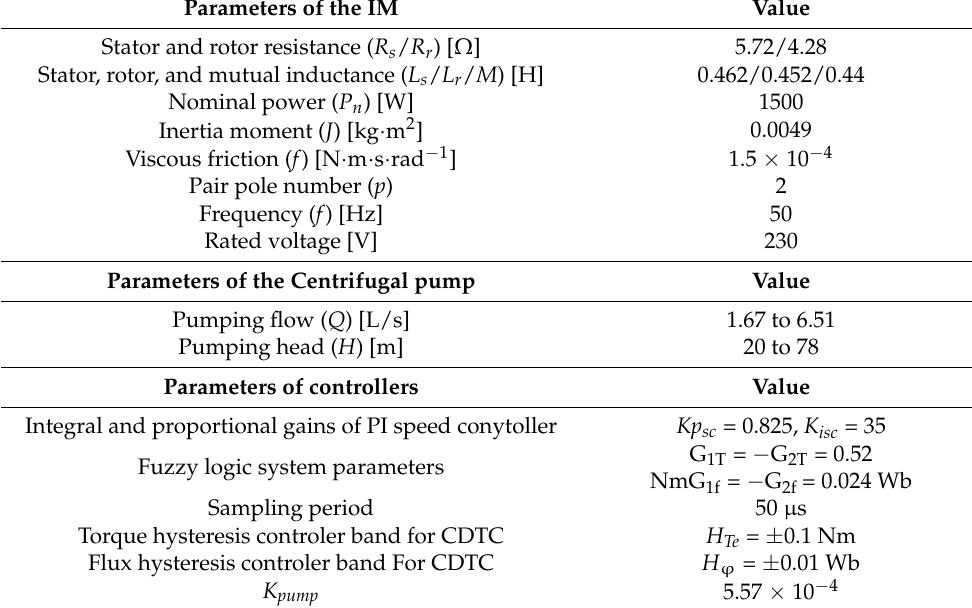
Table 4. Parameters of IM and centrifugal